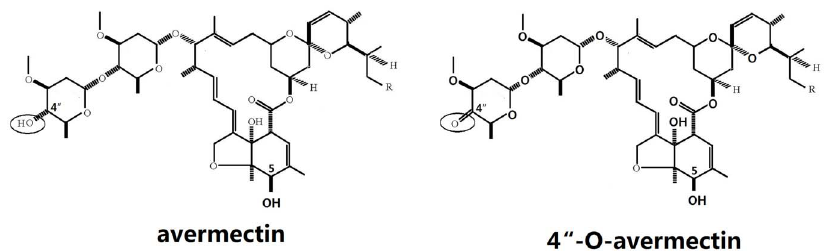
Figure 1. Structures of the avermectin and product 4 0 -O-avermectin.